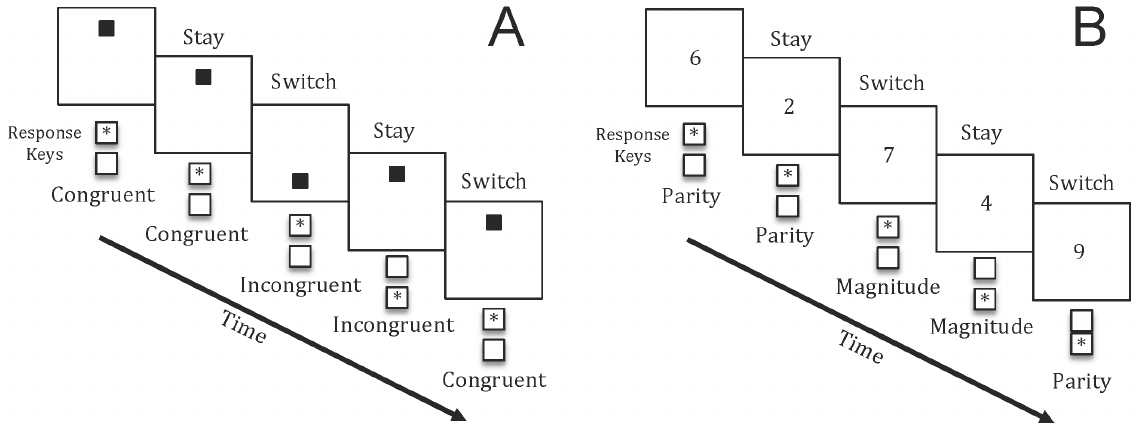
Figure 1. Task Paradigm. Trial events occurring during the spatial (A) and numerical (B) versions of the task-switching task. Participants responded to visual stimuli presented on a computer screen by pressing the button ( asterisk ) appropriate for the specific task contingencies.